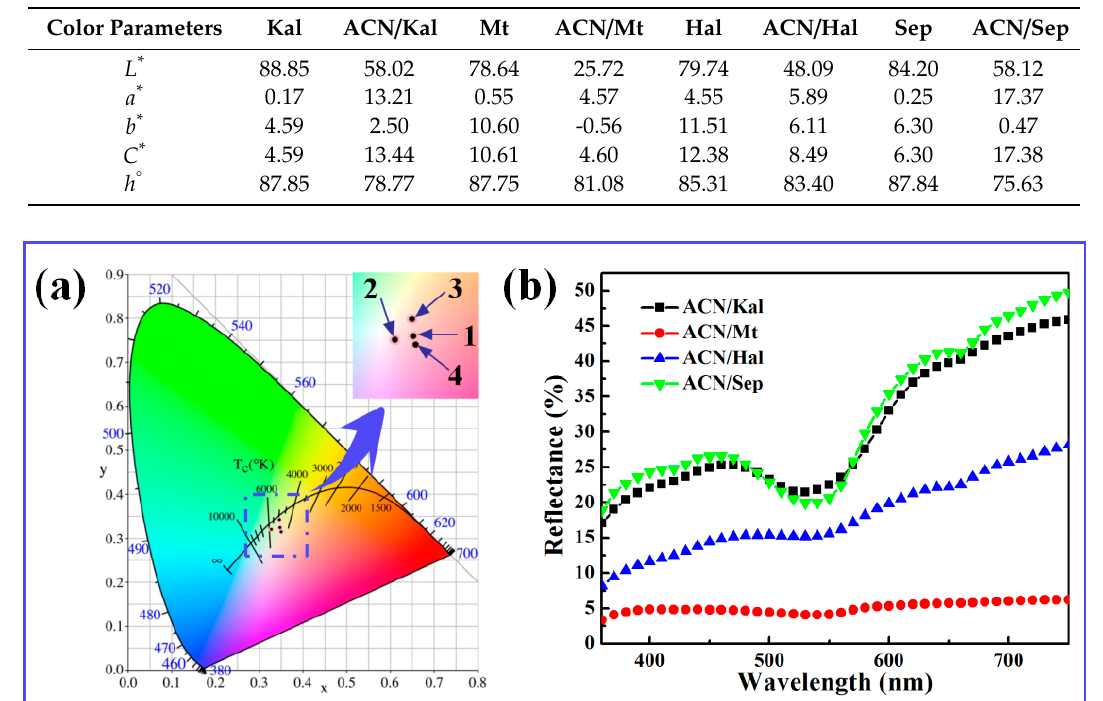
Figure 4. ( a ) Chromatic CIE coordinates and ( b ) UV-vis diffuse reflectance spectra of hybrid pigments